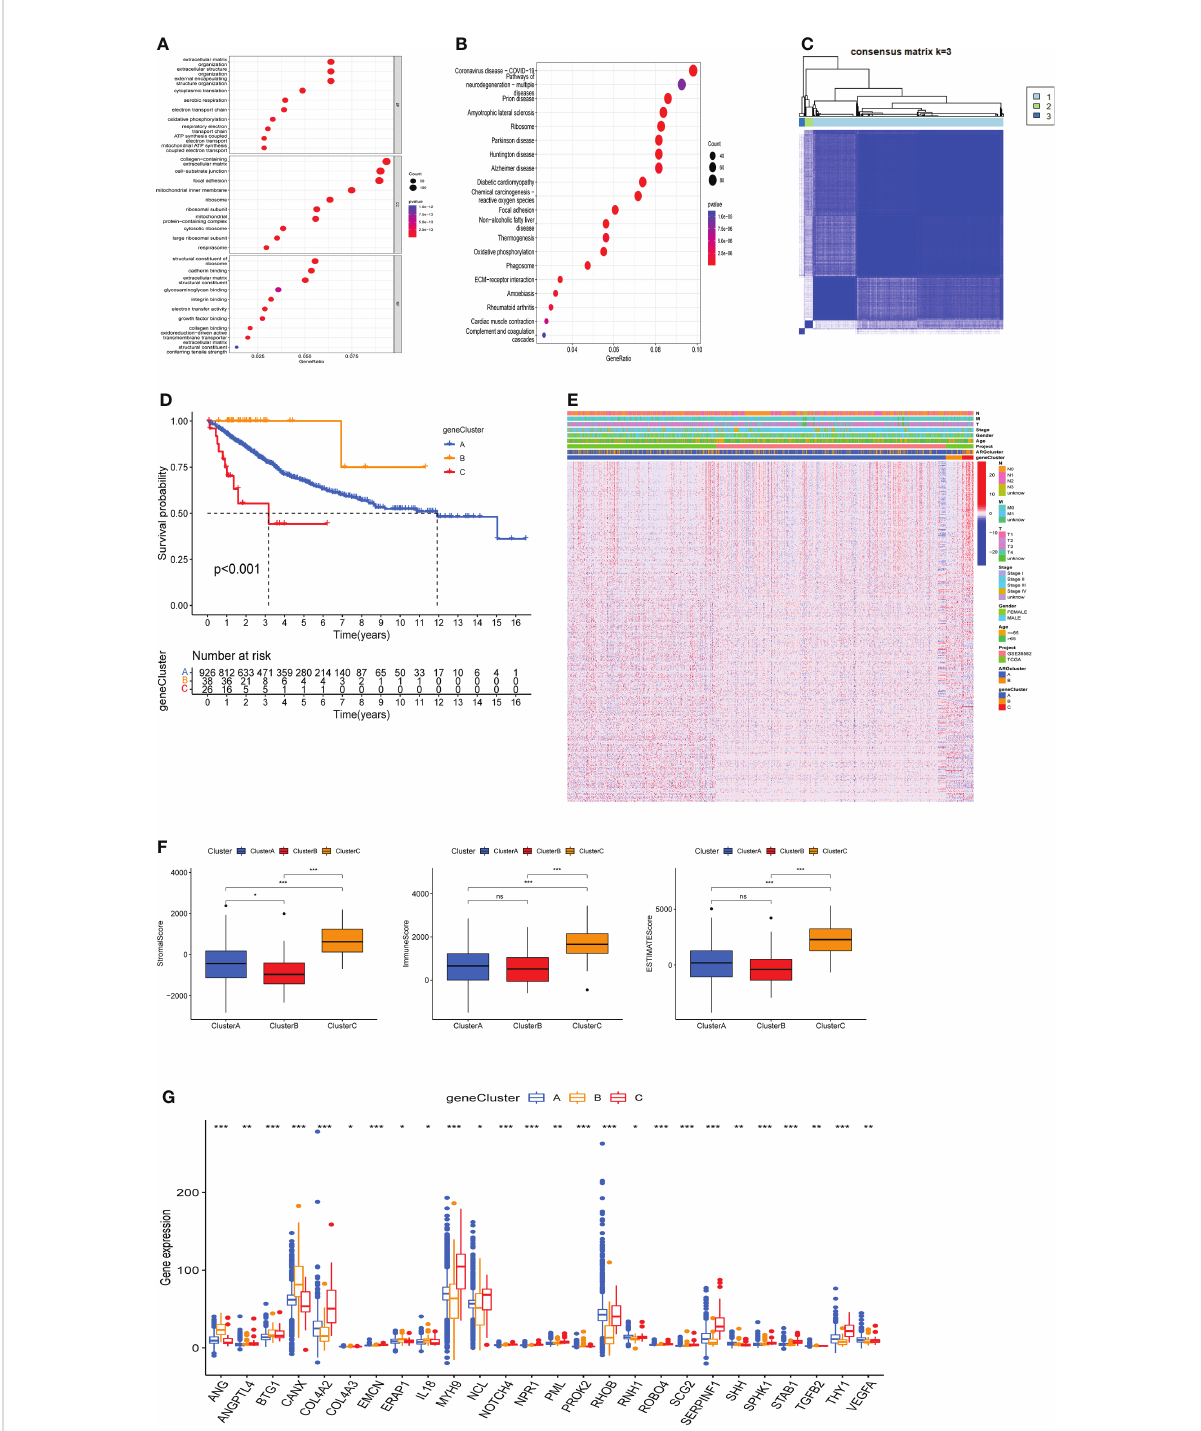
FIGURE 4 Construction of gene clusters based on the differentially expressed genes (DEGs) and analysis of prognosis, pathological features and tumor immune microenvironment (TME) in gene clusters. (A) Gene Ontology (GO) enrichment analysis of DEGs between two ARGclusters. (B) Kyoto Encyclopedia of Genes and Genomes (KEGG) enrichment analysis of DEGs between two ARGclusters. (C) The consensus matrixes for TCGA- COAD cohorts based on the DEGs among the 2 ARG clusters(k=3). (D) Kaplan-Meier analysis showing the different OS of the three gene clusters. (E) Heatmap shows the different clinicopathological features of the three gene clusters. (F) Differences of stromal score, immune score and ESTIMATE score between the 3 gene clusters. (G) Expressions level of ARGs in three gene clusters. Adjusted p-values were shown as ns, no signi fi cant, * P < 0.05, ** P < 0.01, *** P <